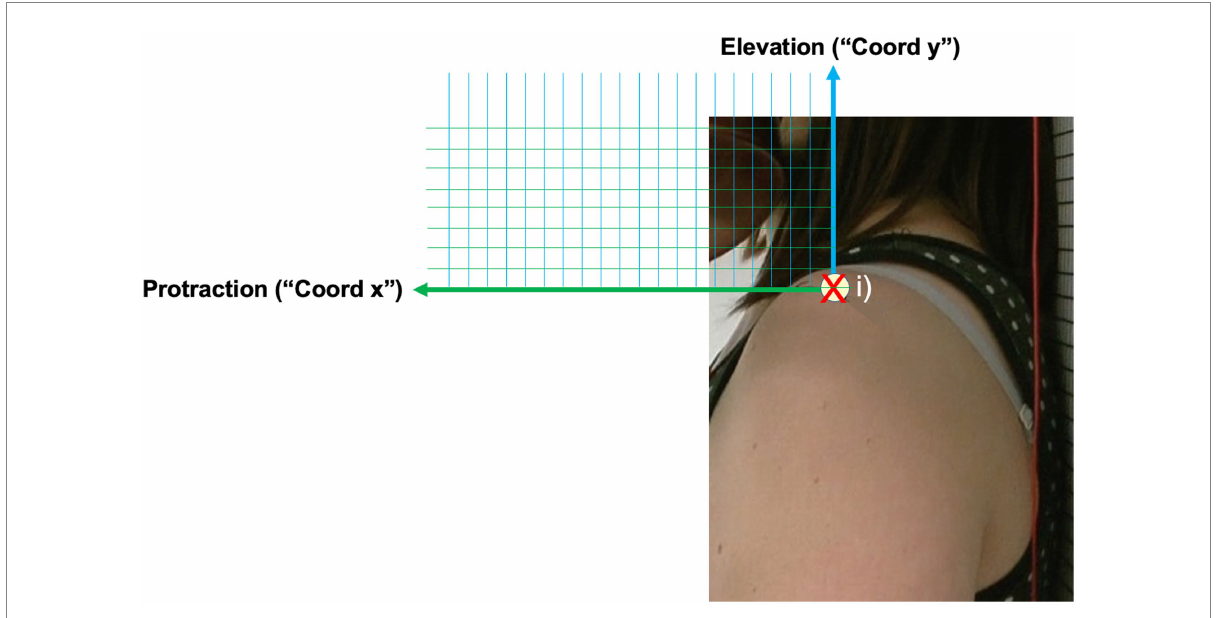
FIGURE 5 Schematic illustration of acromion motion and measuring